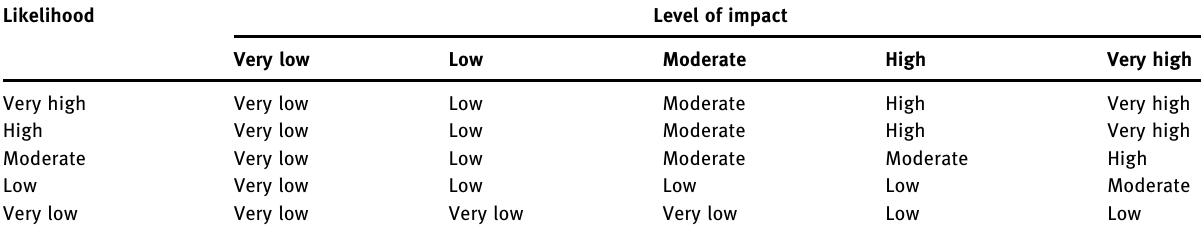
Table 1: Risk level matrix [ 21 ]